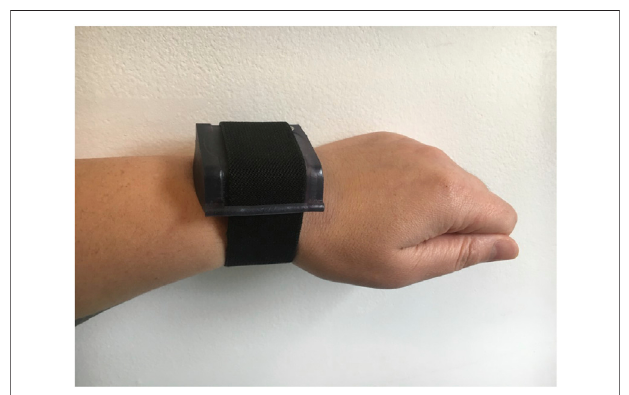
FIGURE 1 | Appearance of the T ’ ena IMU sensor-based system and approximate mounted